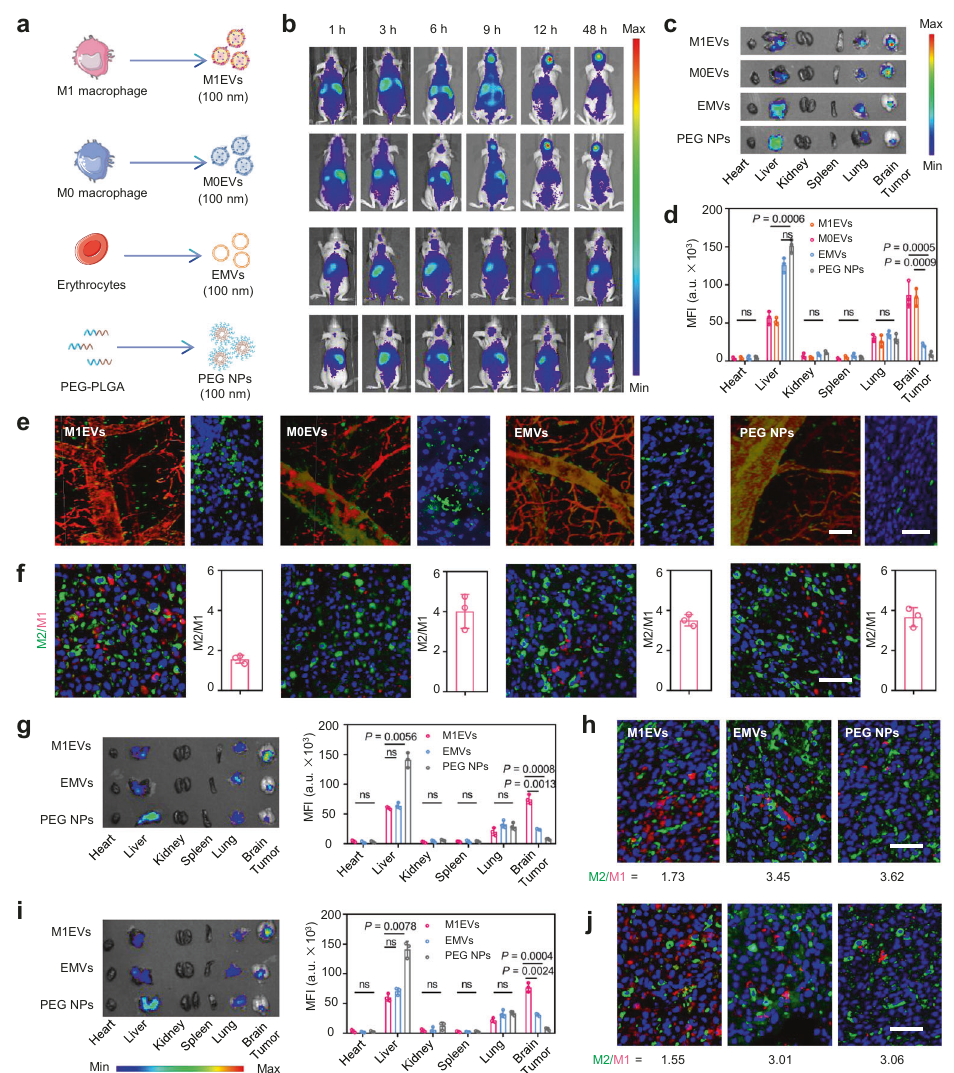
Fig. 2 Macrophage-derived EVs could penetrate the blood-brain barrier (BBB) and ef fi ciently modulated the tumor microenvironment (TME). a . Schematic illustration of the fabrication process for M1EVs (derived from M1 macrophages), M0EVs (derived from M0 macrophages), EMVs (derived from erythrocytes), and PEG NPs (derived from PEG-PLGA materials). b . Representative fl uorescence images of U87MG-bearing mice after intravenous ( i.v .) injection with M1EVs, M0EVs, EMVs, and PEG NPs (all labeled with DiR) at different time points. c . Ex vivo images of the major organs dissected from mice in different groups at 48 h after i.v . injection. d . Quantitative analysis of corresponding fl uorescence signals in panel ( c ). e . In vivo time-lapse two-photon images of the diffusion of M1EVs, M0EVs, EMVs, and PEG NPs acrossed the brain microvascular endothelial cells at 48 h after i.v . injection (left). Tetramethylrhodamine isothiocyanate-Dextran was used to label blood vessels (red). M1EVs, M0EVs, and EMVs labeled with DiO (green); PEG NPs labeled with FITC (green), and corresponding formulation distributions in tumor tissue (right). All images have the same scale of 50 μ m. f . Immuno fl uorescence images of histological sections of M2 and M1 macrophages (left), and quantitative analysis of M2/M1 ratios (right) at 48 h after i.v . injection. All images have the same scale of 50 μ m. iNOS (red, M1 marker), CD163 (green, M2 marker) ( n = 3). g . Ex vivo images of the major organs dissected from G422 bearing mice in different groups (mouse source) at 48 h after i.v . injection (left), and corresponding analysis of ex vivo fl uorescence signals of the major organs dissected from mice in different groups (right). h . Immuno fl uorescence images of histological sections (G422-bearing mice) of M2 and M1 macrophages (right). Scale bar: 50 μ m, iNOS (red, M1 marker), CD163 (green, M2 marker) ( n = 3). i . Ex vivo images of the major organs dissected from GL261 bearing-mice in different groups at 48 h after i.v . injection (left), and corresponding analysis of ex vivo fl uorescence signals of the major organs dissected from mice in different groups (right). j . Immuno fl uorescence images of histological sections (GL261- bearing mice) of M2 and M1 macrophages (right). Scale bar: 50 μ m, iNOS (red, M1 marker), CD163 (green, M2 marker) ( n = 3). Data in d , f , g , and i are presented as the mean ± S.D. Statistical signi fi cance was calculated, compared with the M1EVs group, by one-way ANOVA with a Kruskal-Wallis test ( d , g , i ). ns, not signi fi membrane though incubation at 37 °C to obtain CCA-M1EVs. Construction, characterizations, evaluations of the penetration Transmission electron microscopy (TEM) revealed that the M1EVs capacity, and in vitro synergistic anti-tumor ef fi cacy of CCA-M1EVs exhibited a classical cup-shaped morphology and had an average The above-mentioned results prompted us to build a delivery diameter of ~100 nm (Fig. 3a). Immunoblotting further veri fi ed system based on M1EVs. M1-like macrophages were incubated that M1EVs expressed the small EV markers CD9, CD81, ALIX, with AQ4N to obtain M1EVs loaded with AQ4N in the core TSG101, the macrophage marker F4/80, and the M1-macrophage (A-M1EVs). Subsequently, CPPO and Ce6 were loaded on the lipid